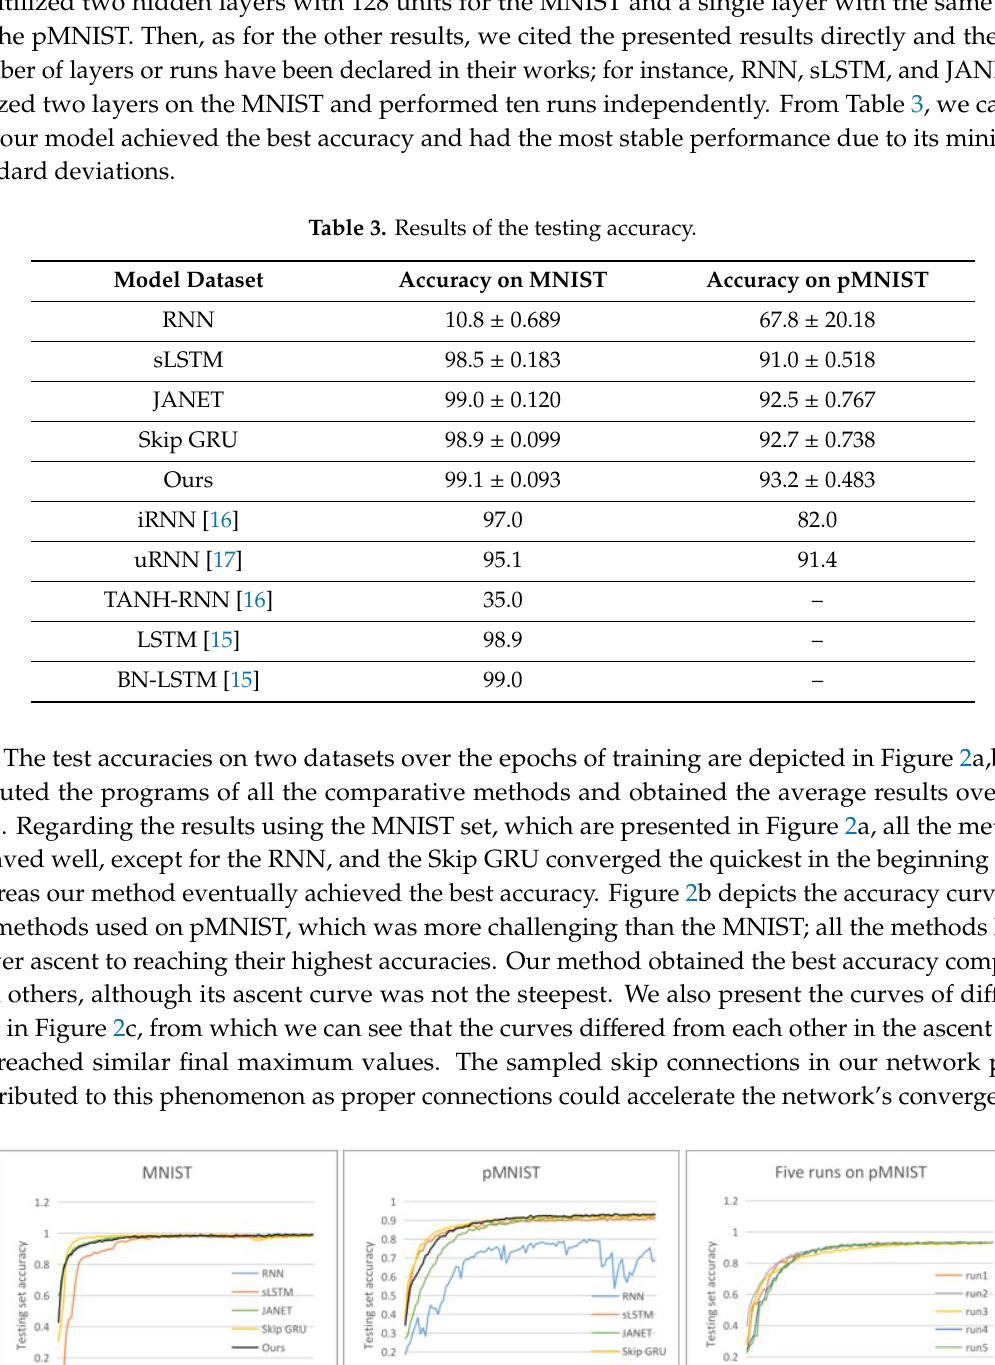
Table 3. Results of the testing accuracy.